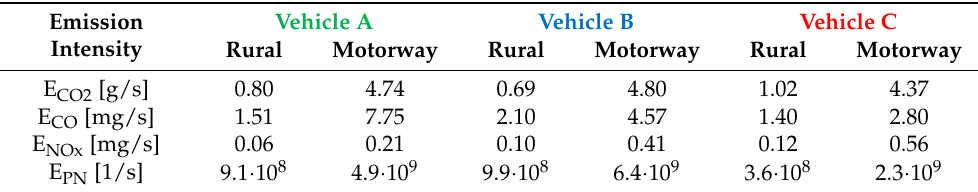
Table 7. The value of the constant emission intensity for the phases of the RDE test (rural, motorway) as the algorithm input